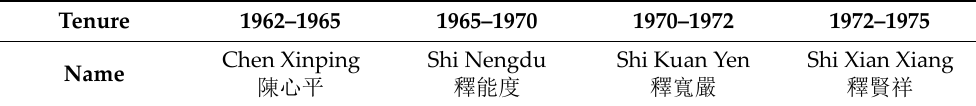
Table 2. Heads of